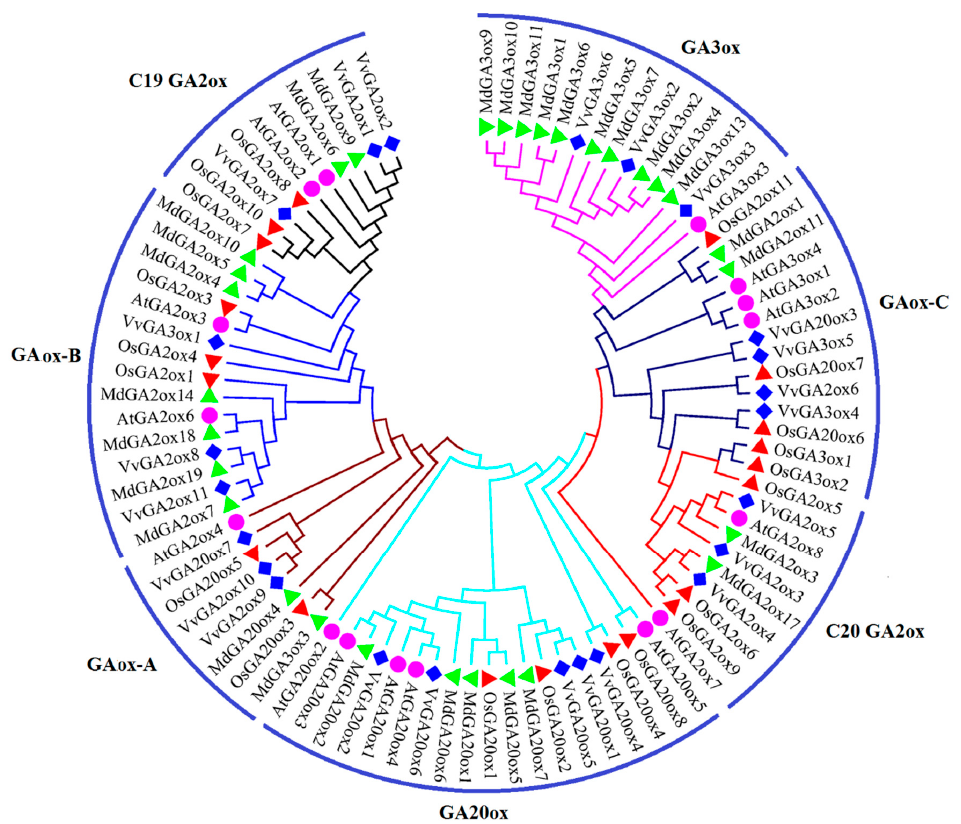
Figure 2. Phylogenetic analysis of GA2oxs , GA3oxs , and GA20oxs in Arabidopsis (At), rice (Os), Malus (Md), and grape (Vv). The amino acid sequences of GA2oxs, GA3oxs, and GA20oxs proteins were aligned with ClustalX, and a phylogenetic tree was constructed using the NJ method in MEGA v.7.0. Each node was represented by a number that indicated the bootstrap value for 1000 replicates. The subgroups were marked by a colorful background.